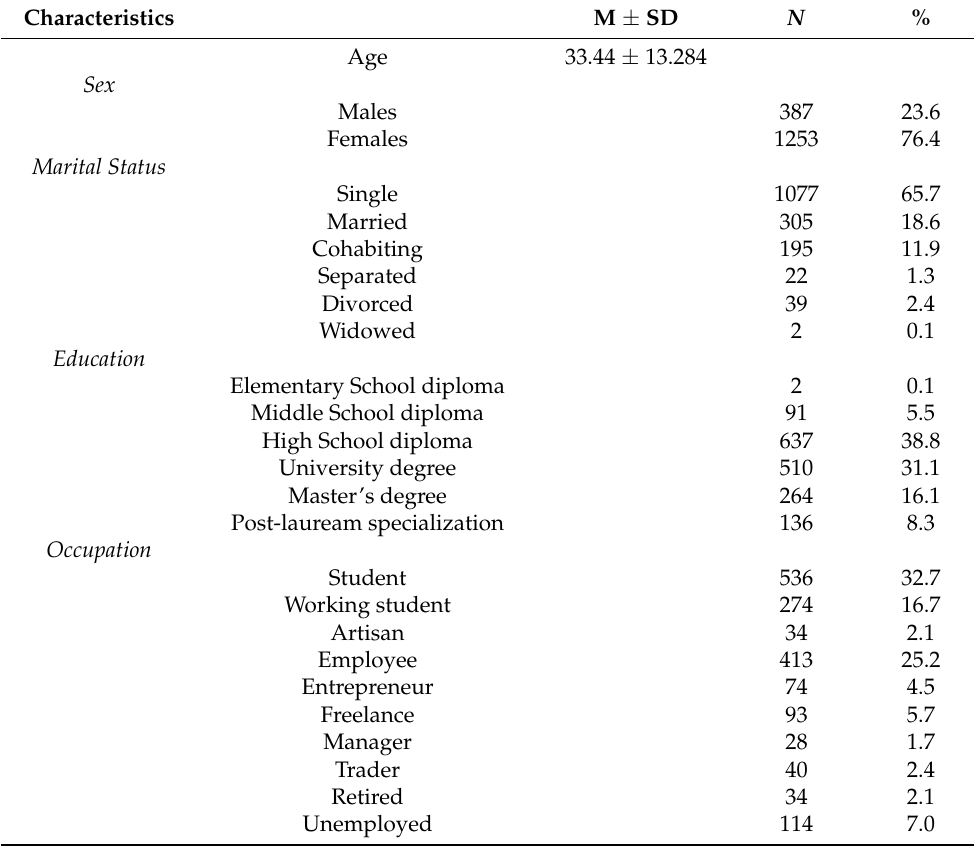
Table 1. Demographic characteristics of the sample ( N =